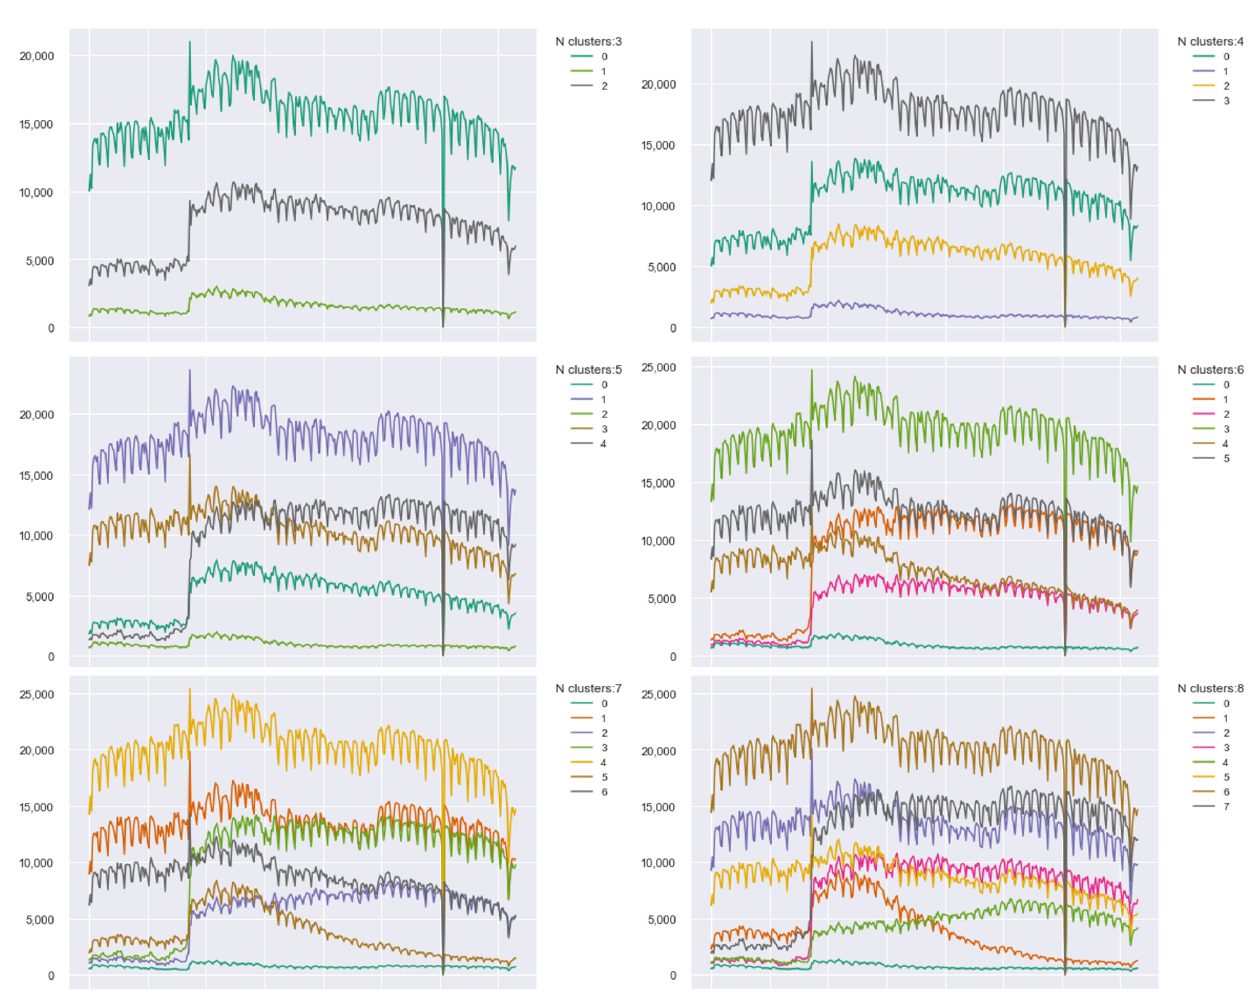
Figure A1. Seasonal k-means clustering sensitivity